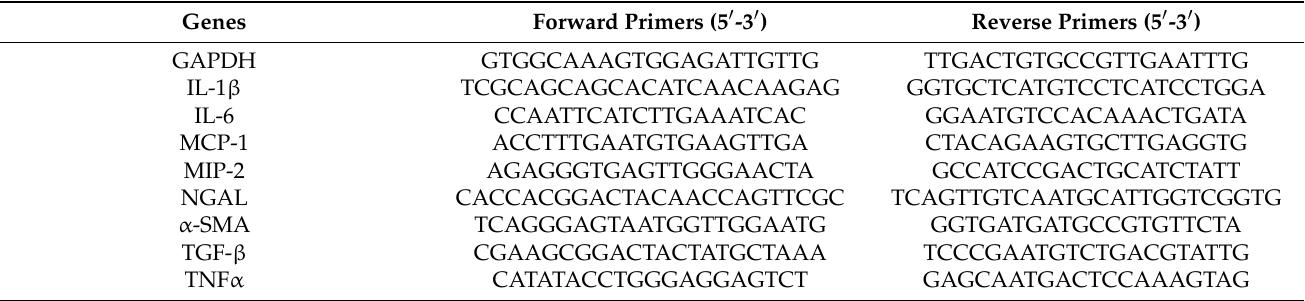
Table 1. The primer sequences used in this